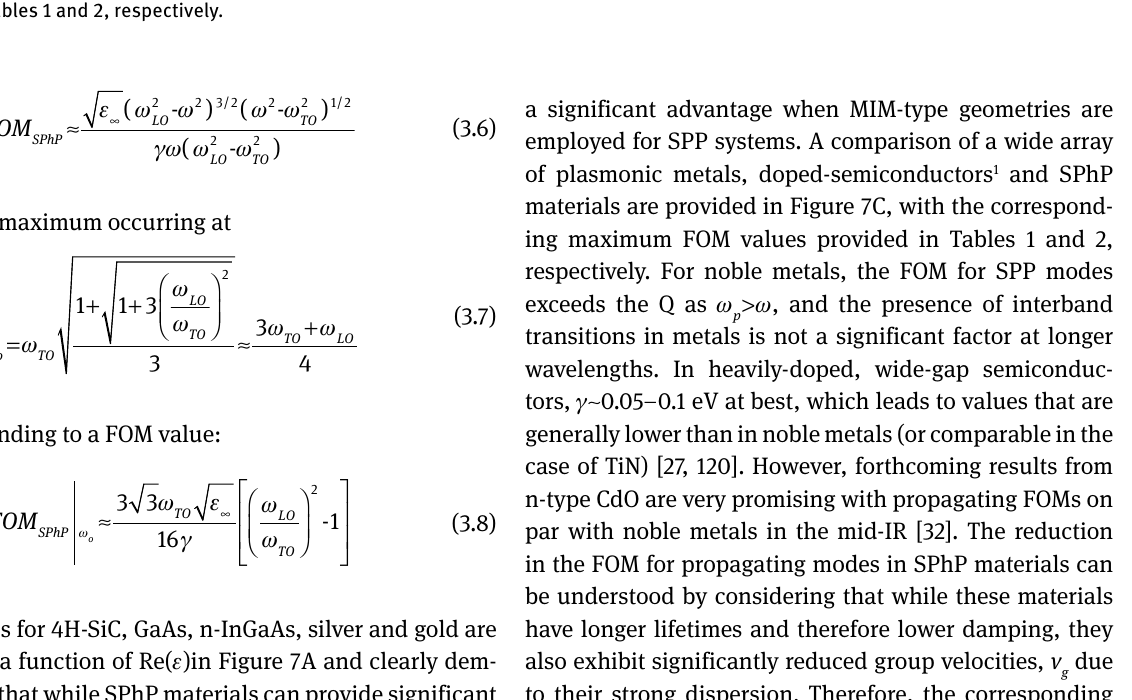
Ga As, Ag and Au over the spectral band corresponding to 0.3 0.7